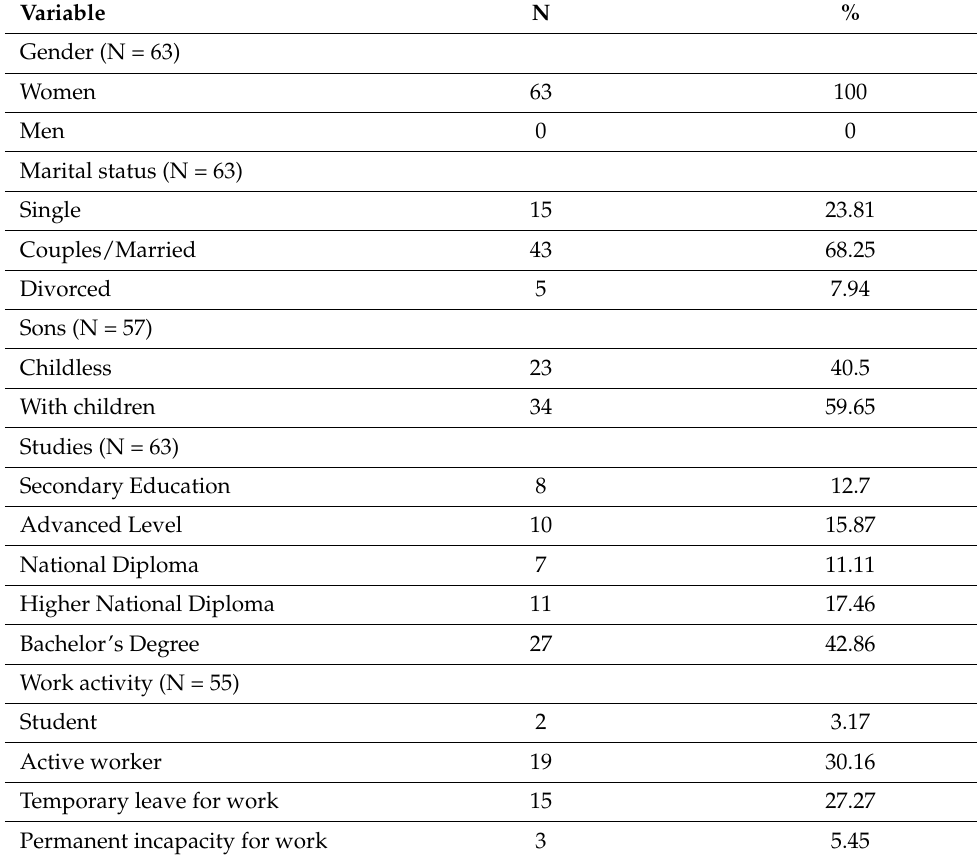
Table 1. Sociodemographic and personal clinical history